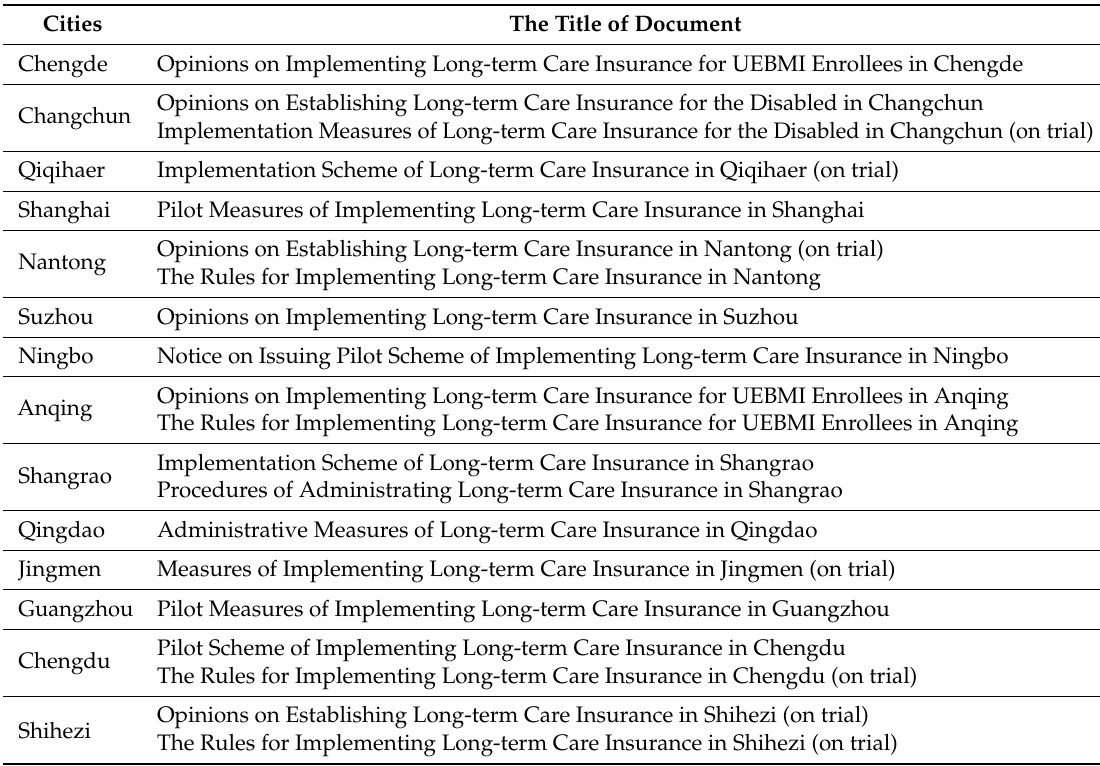
Table A2. List of the main analyzed documents in this